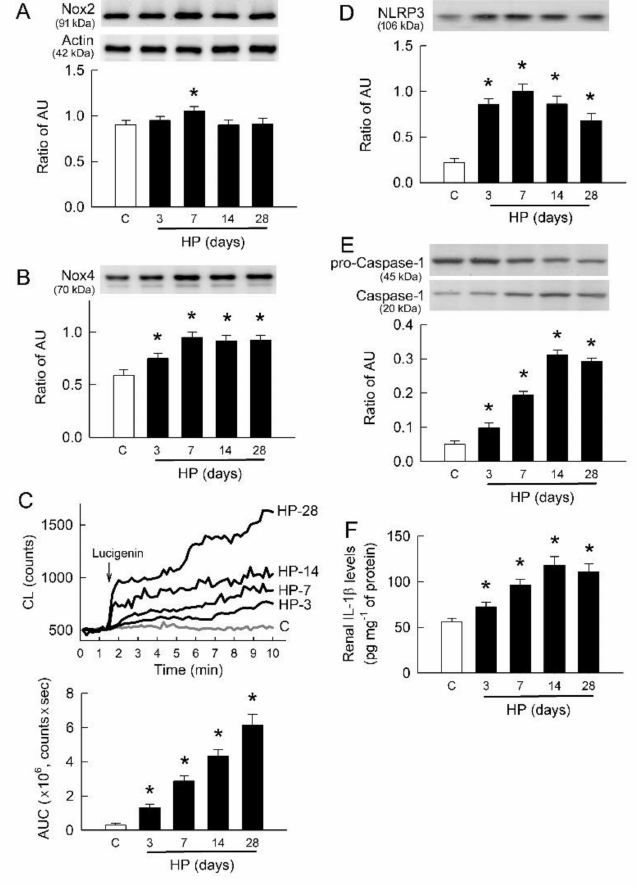
Figure 6. Hyperoxaluria increases Nox4, oxidative stress, and inflammatory mediator expression. ( A , B ) Representative blots show protein expression of Nox2 ( A ) and Nox4 ( B ) (10 µ g of total protein per lane) at appropriate molecular weights. Lower bar graphs (n = 6 in each group) show ratio of abritary unit in band density of Nox2 or Nox4 to actin at 6A. ( C ) Typical tracings show changes in lucigenin-dependent chemiluminescence (CL) counts for superoxide formation in kidney surface of control (C) and 3- to 28-day HP rats. Lower bar graph shows total amount of CL as area under the curve (AUC) for n = 6 in each group and time point. ( D ) Representative blots show protein expression of NLRP3 (10 µ g of total protein per lane). Lower bar graphs (n = 6 per group and time point) show ratio of band density of NLRP3 to actin at 6A. ( E ) Representative blots show pro-caspase-1 (precursor at 45 kDa) and caspase-1 (at 17 kDa) expression using 10 µ g of total protein in each group. Lower bar graph shows densitometrically quantified results by ratio of caspase-1 to pro-caspase-1 to represent caspase-1 activity (n = 6 per group). ( F ) Quantitative results showing increased tissue content of IL-1 β in renal cortex of HP rats (n = 6 per group). * p < 0.05, HP vs. control group analyzed by unpaired t